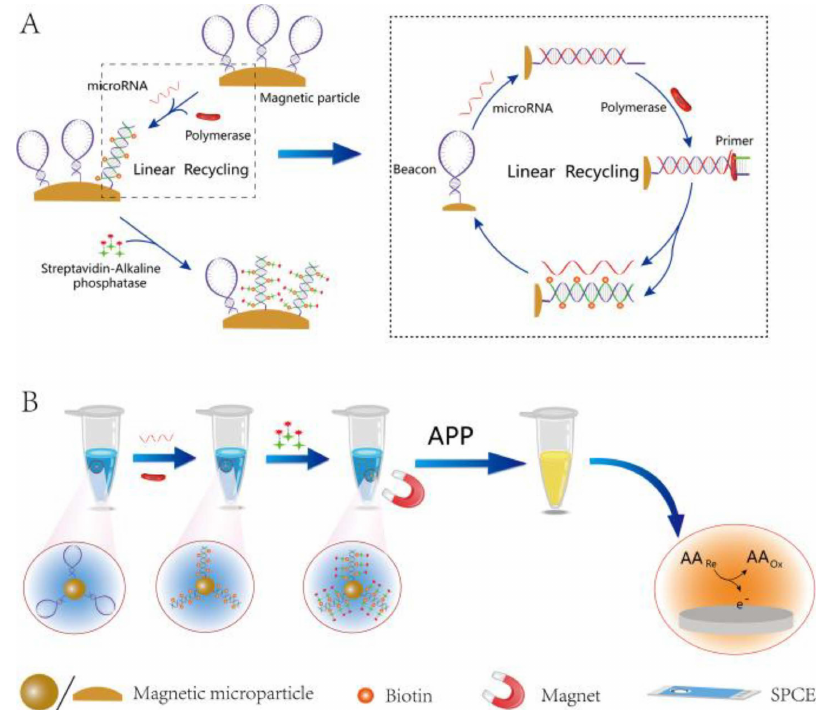
Figure 3. Representative diagram for the isothermal strand-displacement polymerase reaction (ISDPR) amplification ( A ) and the fabrication process of the multienzyme functionalized MMPs and oxidation of ascorbic acid (AA) at an SPCE ( B ). Reprinted from Ref. [4] with